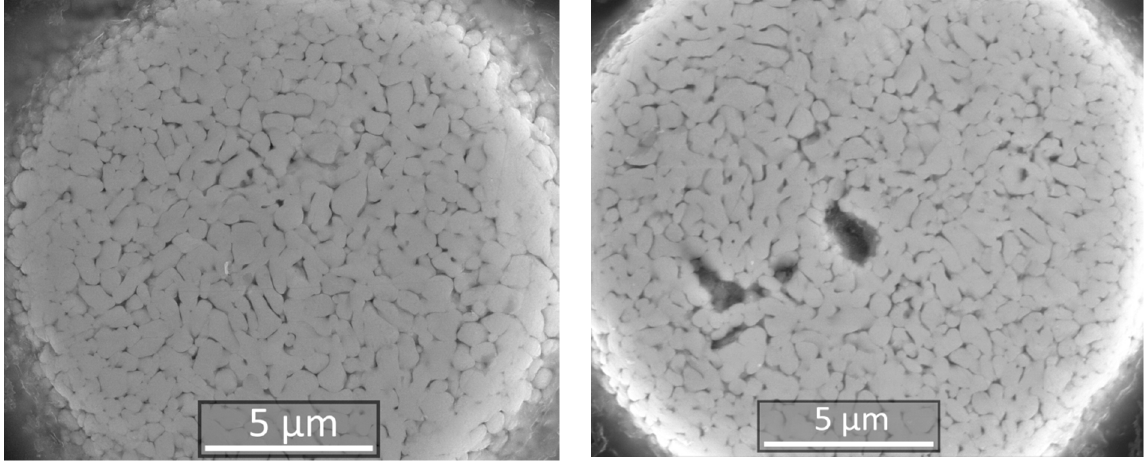
Figure 9. SEM images of W-C-Co spheroidized micropowder cross-section.